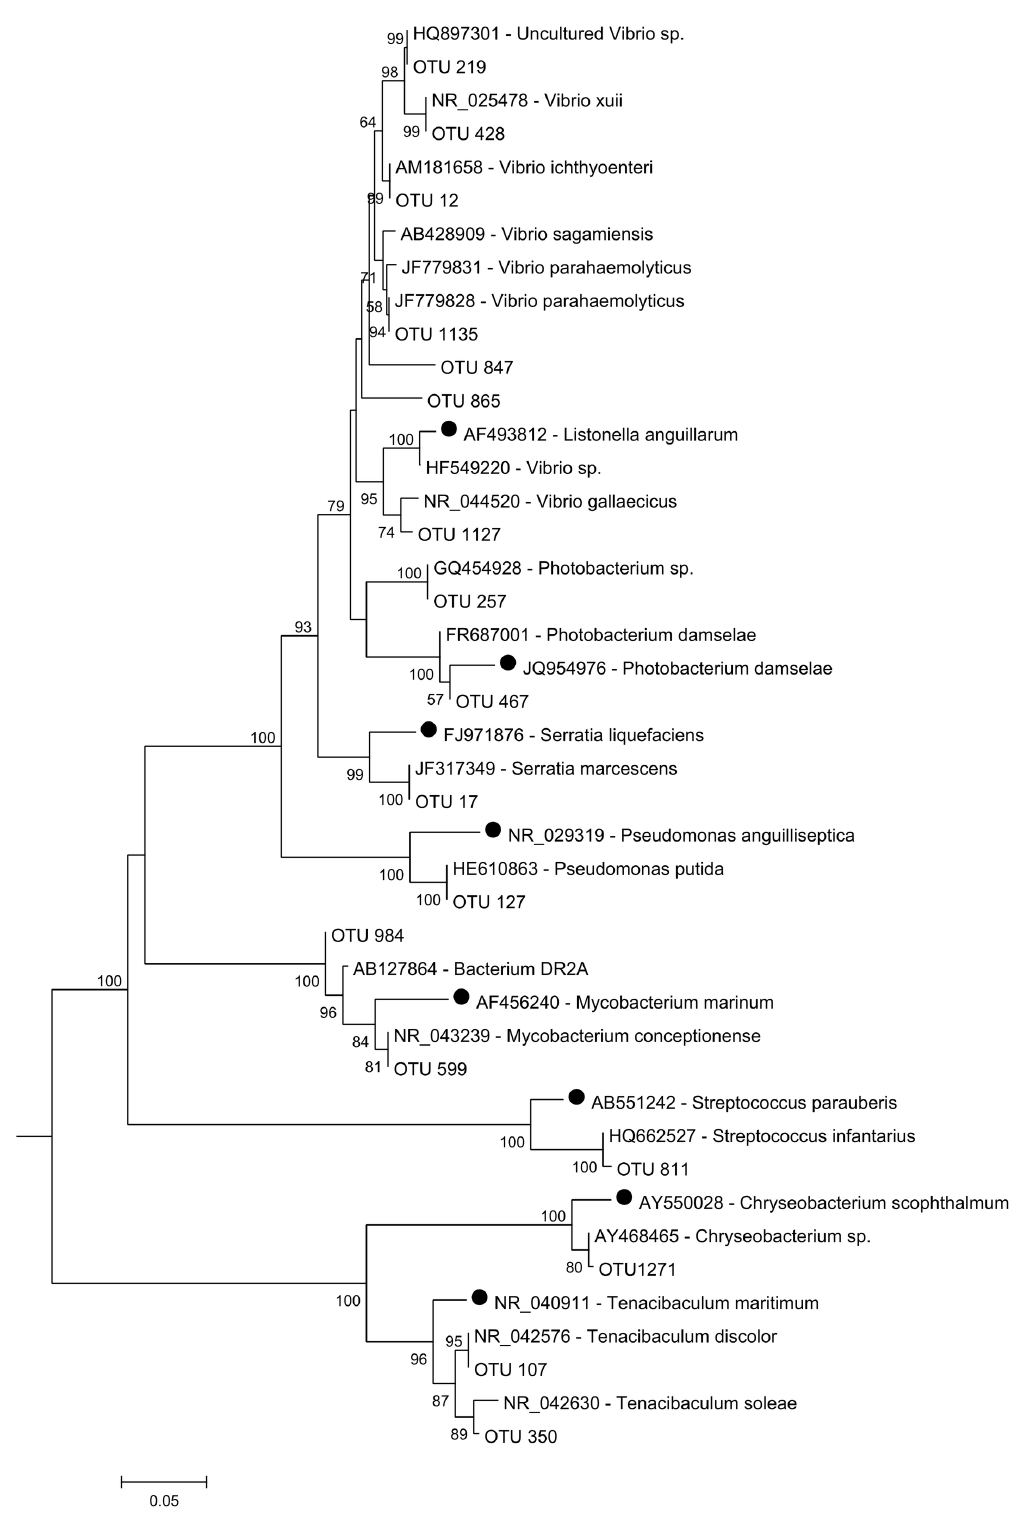
Figure 7. Neighbour-joining phylogenetic tree (16S rRNA gene sequences) of OTUs related potential fish pathogens and their closest relatives (with accession number). Black circles indicate the most frequent pathogens described in literature. Bootstrap values generated from 500 replicates. Values lower than 50% were omitted. doi: 10.1371/journal.pone.0080847.g007 PLOS ONE |